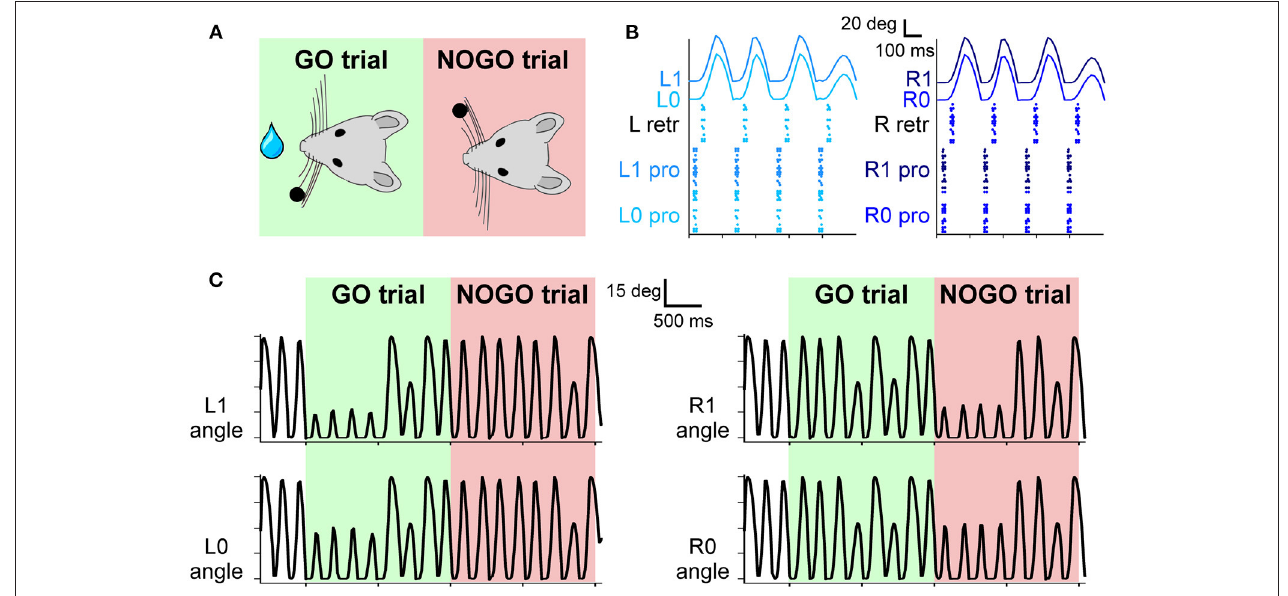
FIGURE 3 | (A) The experimental protocol: during GO trials, a sensory cue (a small bar, depicted as a black dot) is placed in the left whisker field of the mouse. Correct responses lead to a reward (water drop). During NOGO trials, the sensory cue is placed in the right whisker field, and a response does not result in any reward. (B) Spiking activity of motor neurons for protraction and retraction during one trial. Twenty protractors neurons for each whisker and 20 retractor neurons for each side (L and R) fire under the control of the CPG neuron at 4 Hz. The resulting displacement of each whisker is depicted in the upper part of the panel. (C) Angular displacement of the four whiskers during one GO and one NOGO trial. During the GO trial, in the first second, left whiskers hit the sensory cue bar, placed in the left whisker field. On the other hand, during the NOGO trial, the right whiskers hit the sensory cue bar placed in the right whisker